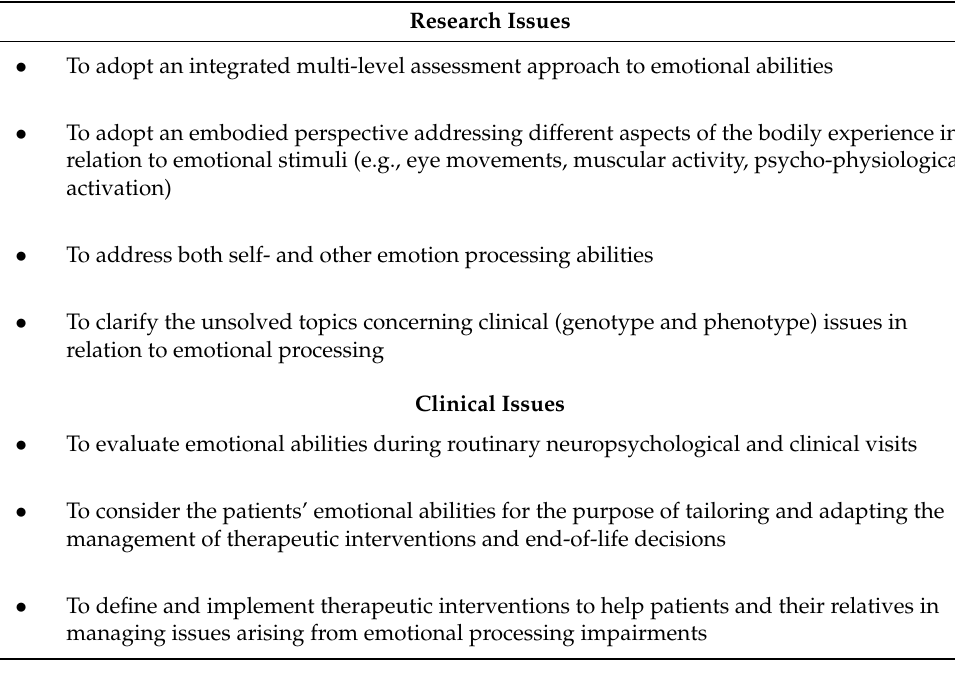
Table 2. Bullet points about clinical and research